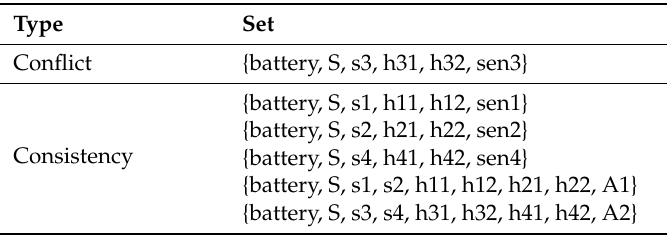
Table 4. Conflict and Consistency Found by MCMC-LTMS.